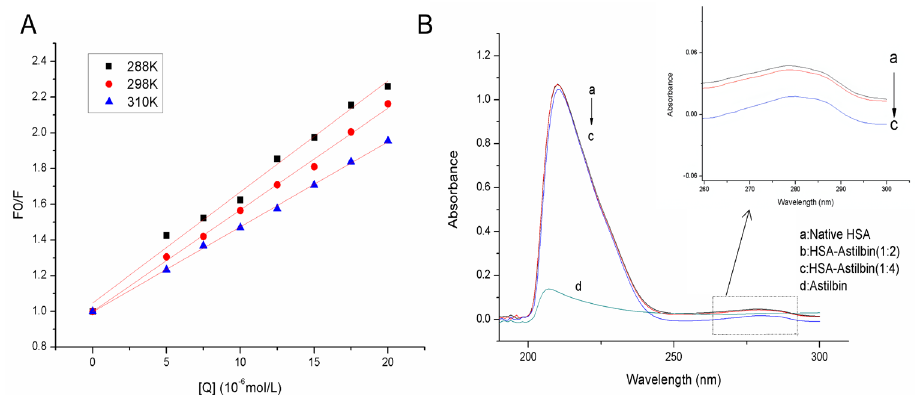
Figure 2. ( A ) Stern-Volmer plots for the astilbin − HSA system at three temperatures; ( B ) UV-Visible absorption spectra of HSA in the absence and presence of astilbin. C HSA : 1.0 × 10 − 6 mol · L − 1 . C astilbin (a → c): 0, 2.0, 4.0 × 10 − 6 mol · L − 1 . Inset: the absorption spectra of HSA varied between 260